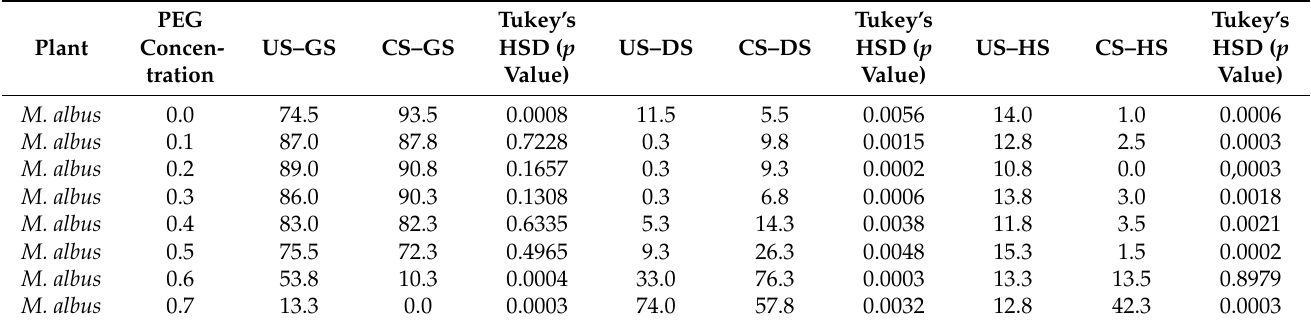
Table A8. Results of Tukey’s HSD test— M. albus .